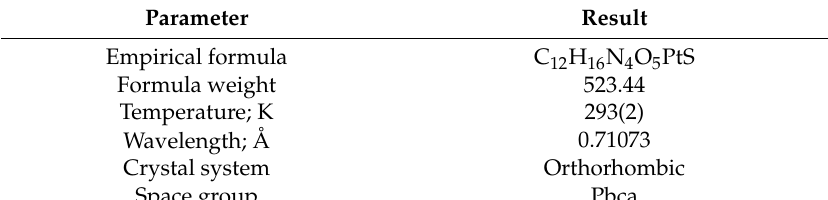
Table 1. Crystal data and structure refinement for ( 5 )